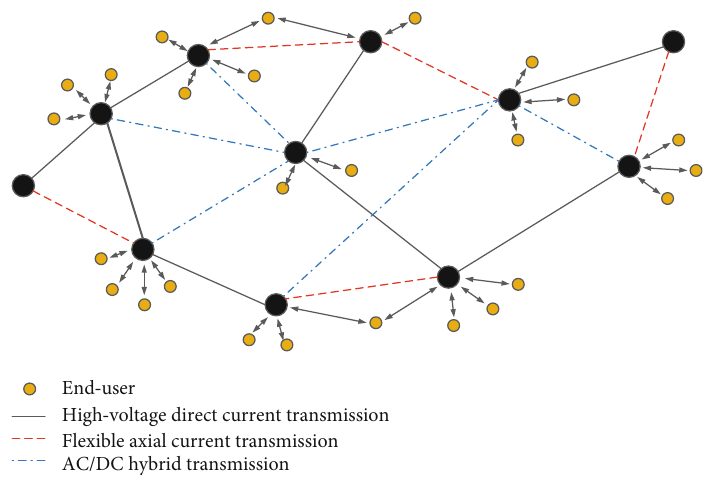
Figure 1: Power network